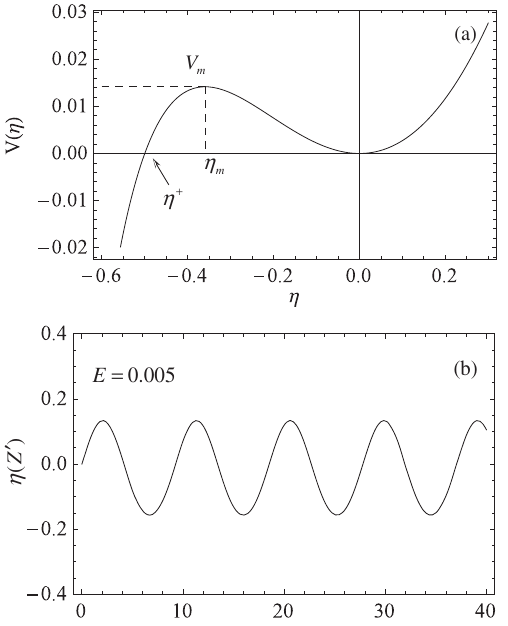
FIG. 14. Plots are shown for (a) V ð η Þ versus η , and (b) η ð Z 0 Þ versus Z 0 , obtained from Eq. (94) for M 2 ¼ 0 . 5 , η 0 ð 0 Þ ¼ 0 . 1 , E ¼ ð 1 = 2 Þ½ η 0 ð 0 Þ(cid:4) 2 ¼ 0 . 005 , η þ ¼ − 0 . 5 ,